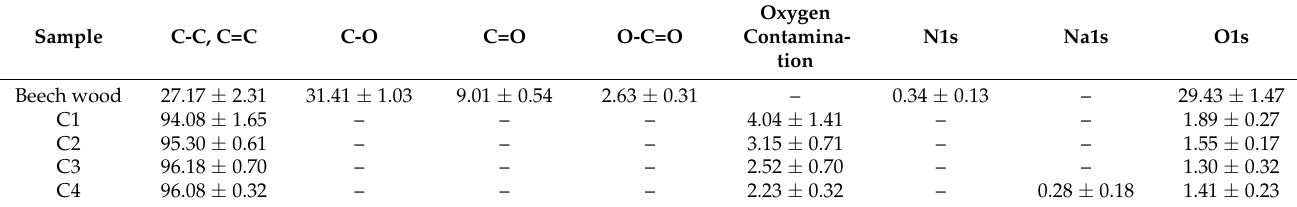
Table 1. Chemical composition in atom-% of the wood reference and the four different parylene layers ( n = 6). Sample